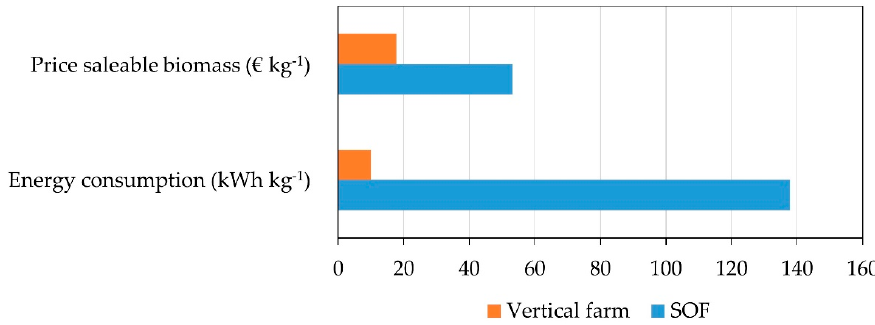
Figure 11. Energy consumption per kg of biomass SOF (blue), and vertical farm (orange) (adapted from [14]).